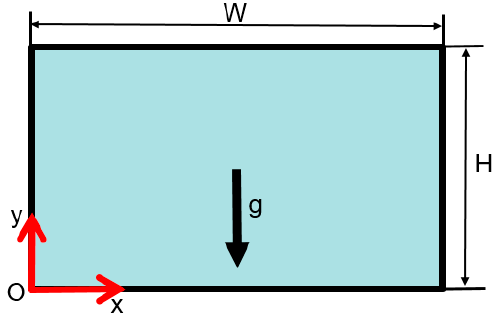
Figure 1. The schematic of rectangular section.